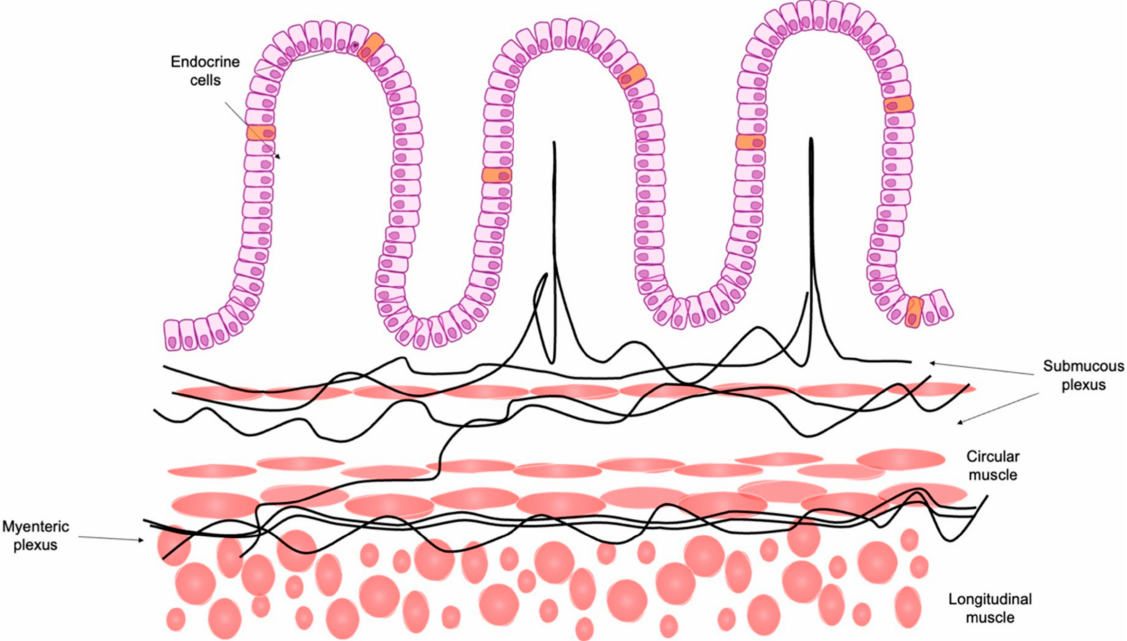
Figure 4. Schematic representation of the enteroendocrine cells, in particular, a focus on their anatomic relationship with the enteric nervous system. Figure modified from El-Salhy M., 2020